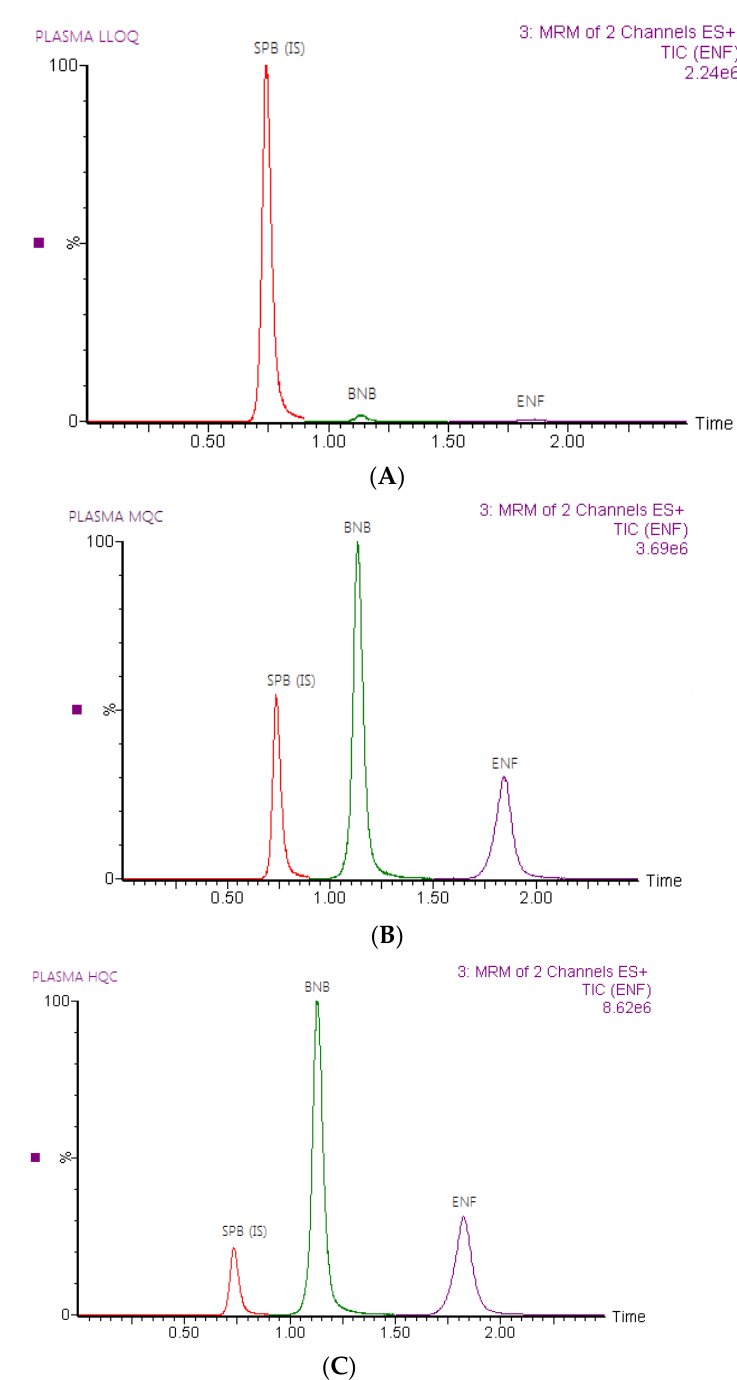
Figure 3. Representative total ion chromatograms of rat plasma spiked with LLOQ ( A ), MQC ( B ), and HQC ( C ); for encorafenib (1.86 min), binimetinib (1.14 min) and IS (0.73 min).